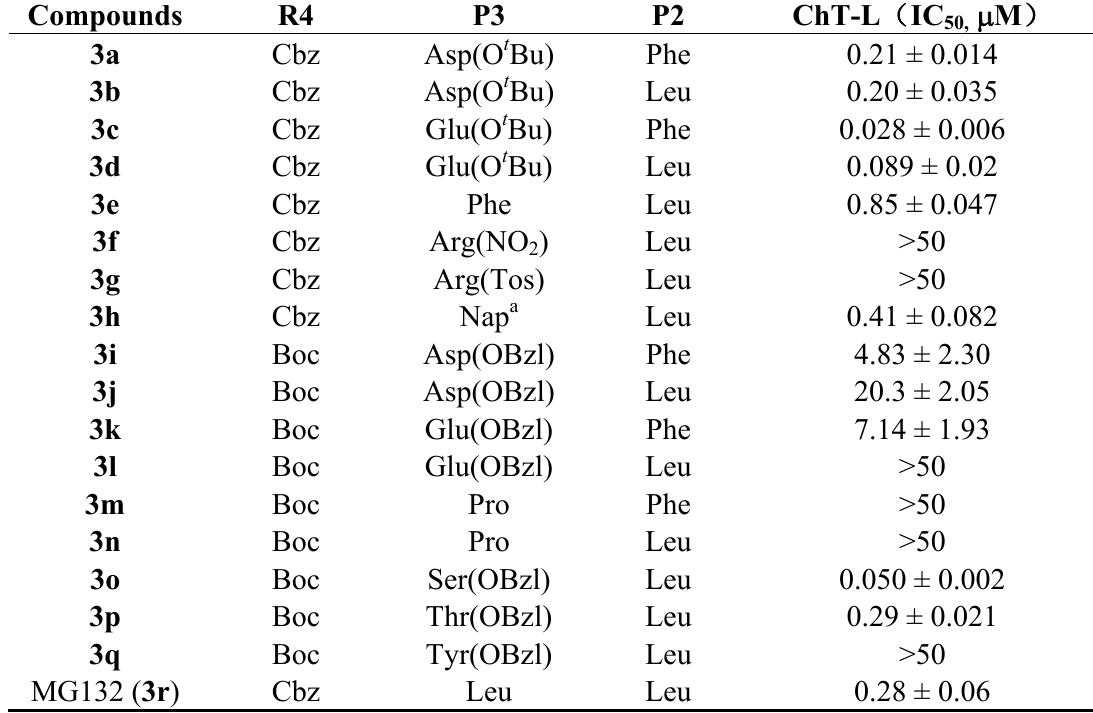
Table 1. Inhibition of peptide aldehydes to ChT-L activity of 20S